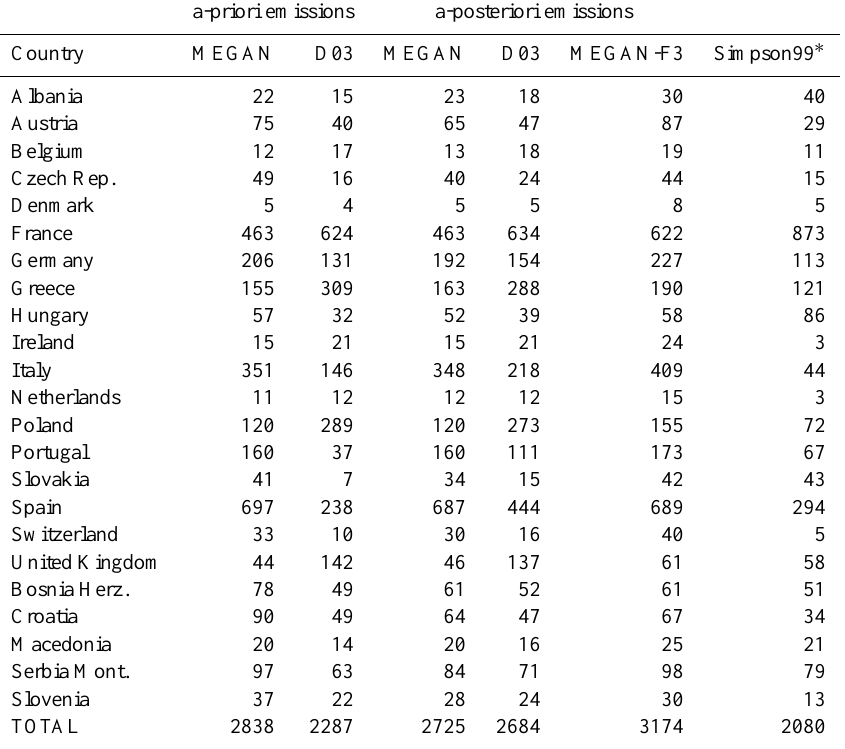
Table 3. A-priori and a-posteriori (OMI-derived) European annual isoprene emissions in 2005 split at country scale. The label MEGAN-F3 refers to inversion performed assuming a flat uncertainty of a factor of 3 for isoprene emissions. Emissions in units of